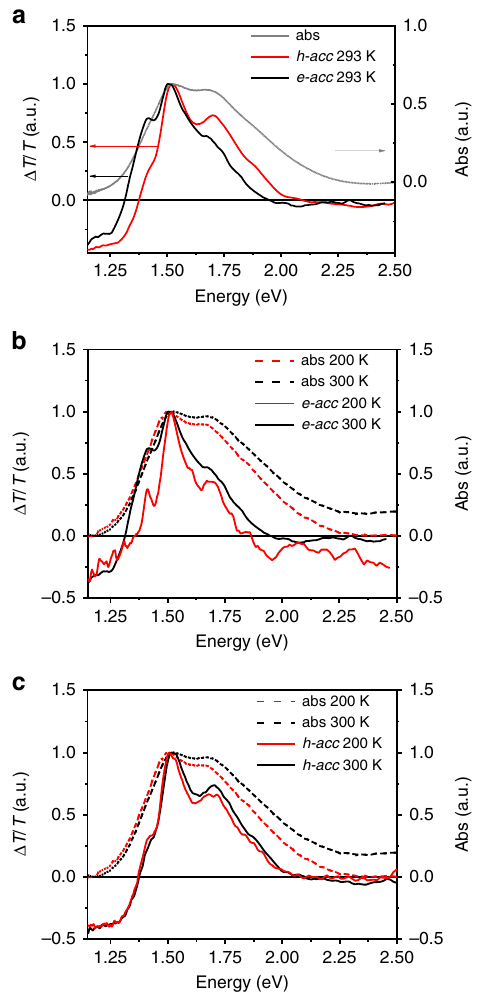
Fig. 3 Normalized temperature-dependent CMS (continuous line) and absorption spectra (dashed line). a Comparison between absorption spectra, h-acc and e-acc CMS spectra acquired at room temperature. b Comparison between absorption spectra and e-acc CMS spectra acquired at 300 and 200 K. c Comparison between absorption spectra and h-acc CMS spectra acquired at 300 and 200 K ( e-acc : V g = 30 V; V pp = 40 ± 20 V; h-acc : V g = − 30 V; V pp = 40 ± 20 V). The selected temperatures allow comparing the CMS spectra without incurring in the presence of lineshapes due to the interference from electroabsorption features (see Supplementary Figs. 7 and